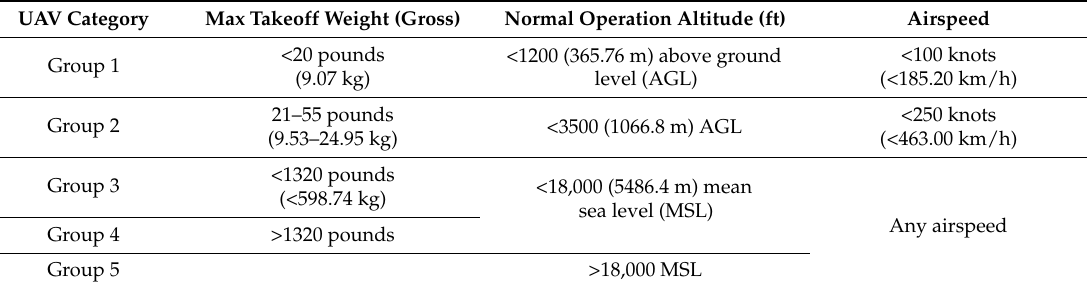
Table 1. UAV categorization used by the U.S. Department of Defense